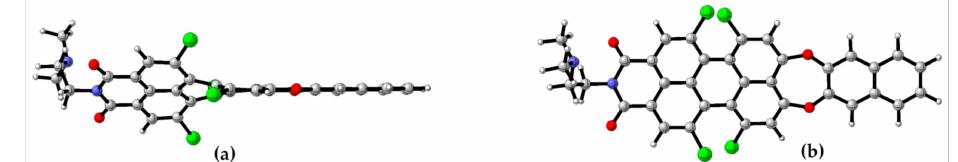
Figure 4. TDPBE0/6-311+G(2d,p)-optimized excited state geometry (S 1 ) of 1b in methanol. ( a ) Side view. ( b ) Top view.